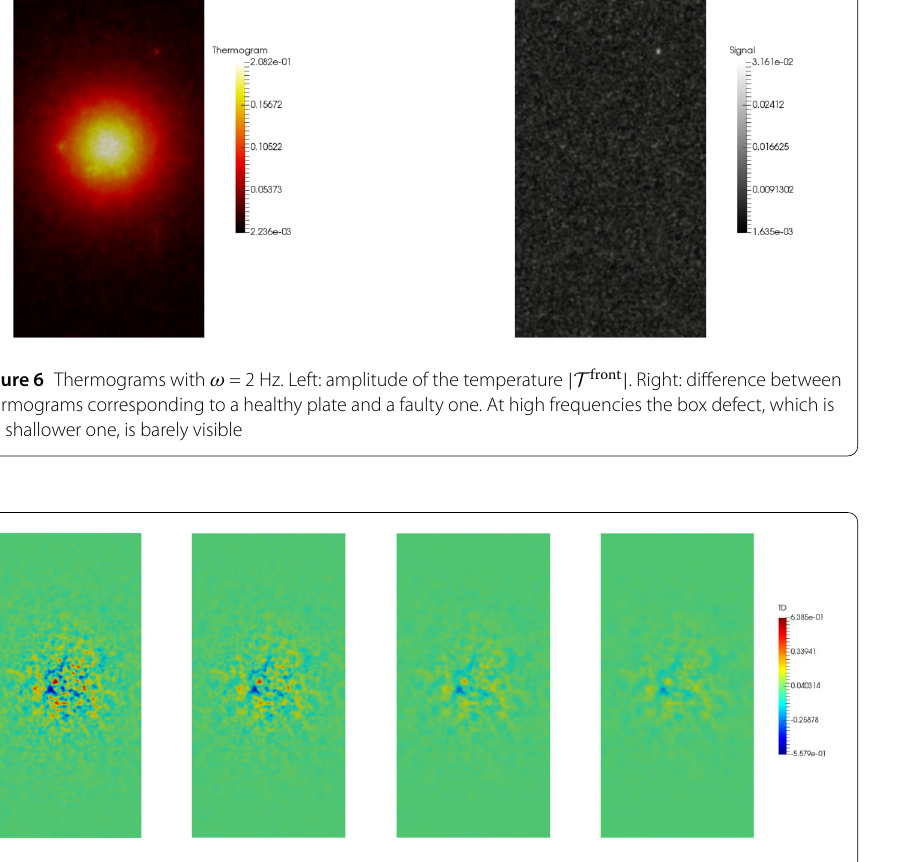
Figure 7 Values of the topological derivative on several planes of the form x = x 0 . First: x = – (cid:2) x /2. Second: x = – (cid:2) x /4. Third: x = 0. Forth: x = (cid:2) x